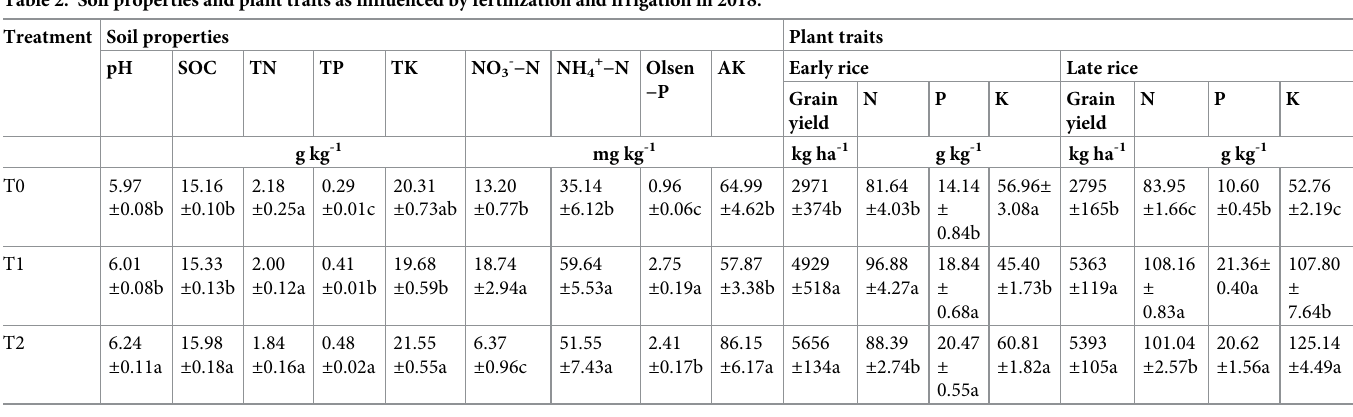
A total of 17 runoff-producing rainfall events were recorded during the rice growing season from 1 May to 9 September 2018, and they ranged from 7.0 to 101.7 mm. Among them, three extreme precipitation events with a daily rainfall greater than 60.0 mm were observed, 67.0 mm on June 21, 89.0 mm on July 10, and 101.7 mm on September 6 (Fig 2). High runoff fluxes